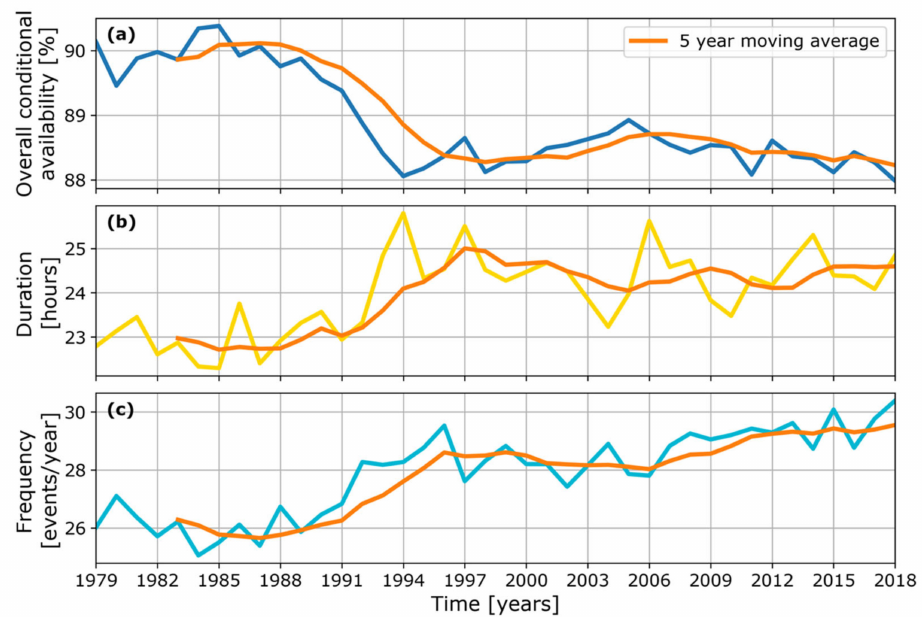
Figure 8. Identifying global trends based on: ( a ) the overall annual average conditional availability; ( b ) duration; ( c ) frequency; from 1979 to 2018. The orange line represents the 5-year moving